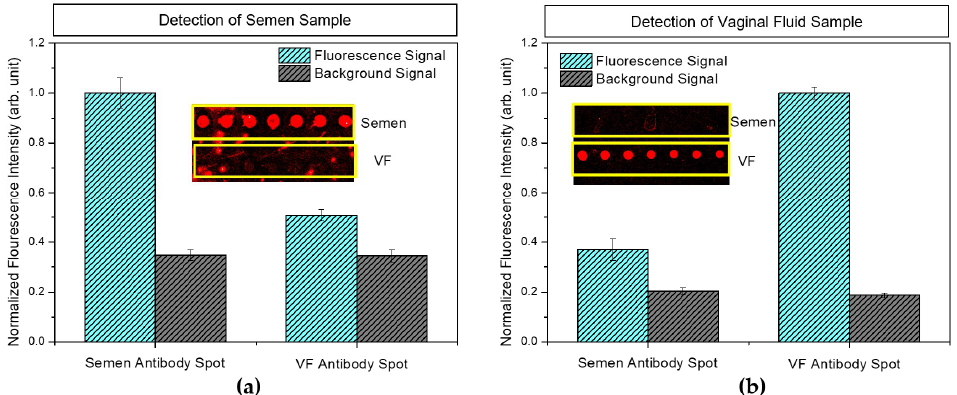
Figure 4. Measured fluorescence signal from the semen antibody spots and vaginal fluid (VF) antibody spots for ( a ) the 12 µ g/mL semen sample and ( b ) the 1 µ g/mL VF sample. Fluorescence images are inserted at the center of each graph (top: Semen antibody spots, bottom: VF antibody spots).